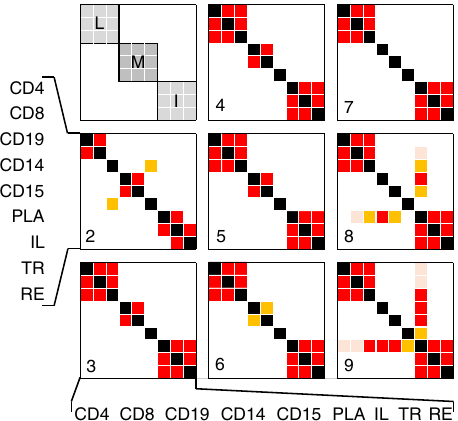
Fig. 5 Signi fi cance of the excess sharing of cRM between cell types. (red: p < 0.0002 (Bonferroni corrected 0.0144), orange: p < 0.001 (0.072), rose: p < 0.01 (0.51)). The numbers in the lower-left corner of the squares indicate which cRM were used for the analysis: (2) cRM affecting no more than two cell types, (3) cRM affecting no more than three cell types, etc. The upper-left square indicates the position of the lymphoid cell types (L) (CD4, CD8, CD19), the myeloid cell types (M)(CD14, CD15, PLA), and the intestinal cell types (I)(IL, TR, RE). For each pair of cell types i and j , we computed two p values, one using i as reference, the other using j as reference (Methods). Pairs of p values were always